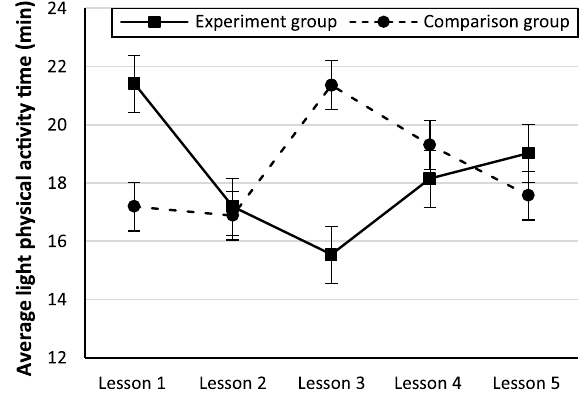
Figure 1. Light physical activity time across the lessons.